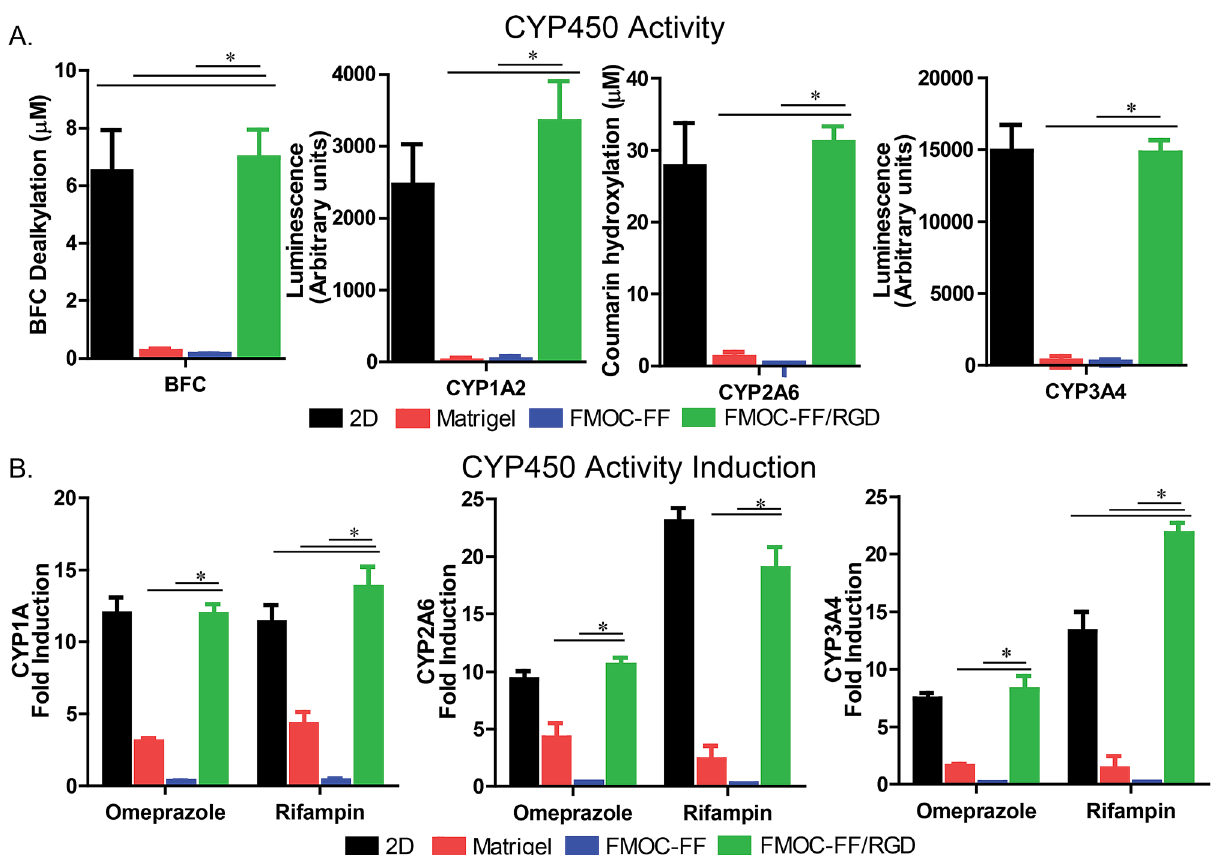
Figure 4. Cytochrome P450 enzyme activity assays for BFC, CYP1A2, CYP2A6 and CYP3A4 for primary human hepatocytes in hydrogel constructs at Day 14 of culture in hydrogel constructs (18 days after initial cell aggregation). ( A ) CYP450 Activity induction assay using Omeprazole and Rifampin for CYP1A, CYP2A6 and CYP3A4 for primary human hepatocytes in hydrogel constructs at day 14 of hydrogel culture. ( B ) (*designates P < 0.05). PowerPoint Professional Plus 2013 and Graphpad Version 6.0 was used to make the